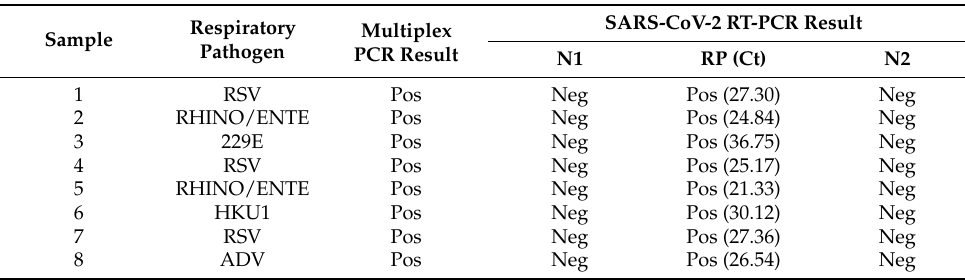
Table 3. Results of the analysis of the cross-reactivity of the assay based on the CDC protocol against other respiratory viruses.